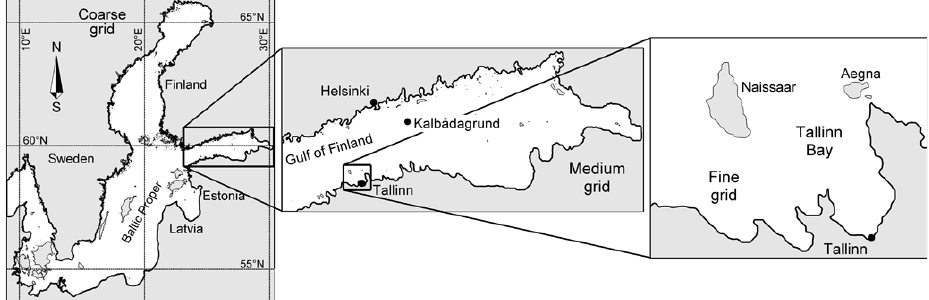
Fig. 1. Computational areas of the triple-nested wave model applied to the Tallinn Bay